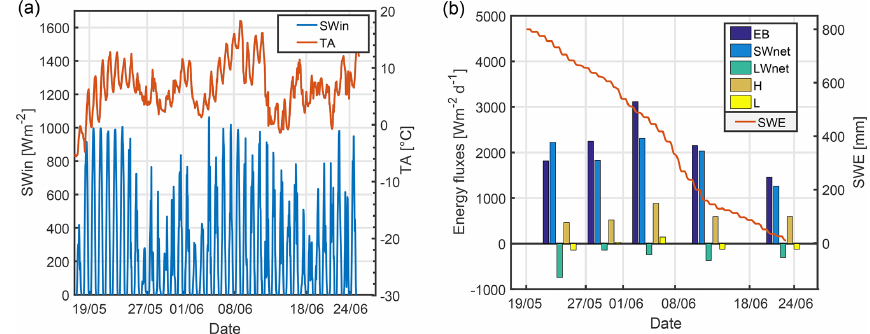
Figure 4. Measured (a) and modelled (b) values at the FRG station, showing energy fluxes per day for periods between UAV flights as modelled by CRHM. EB is the total energy flux; SW net and LW net are net shortwave and longwave radiation respectively; H and L are sensible and latent heat fluxes, respectively. Heat advected by rain and ground heat flux that only have small contributions are not shown.